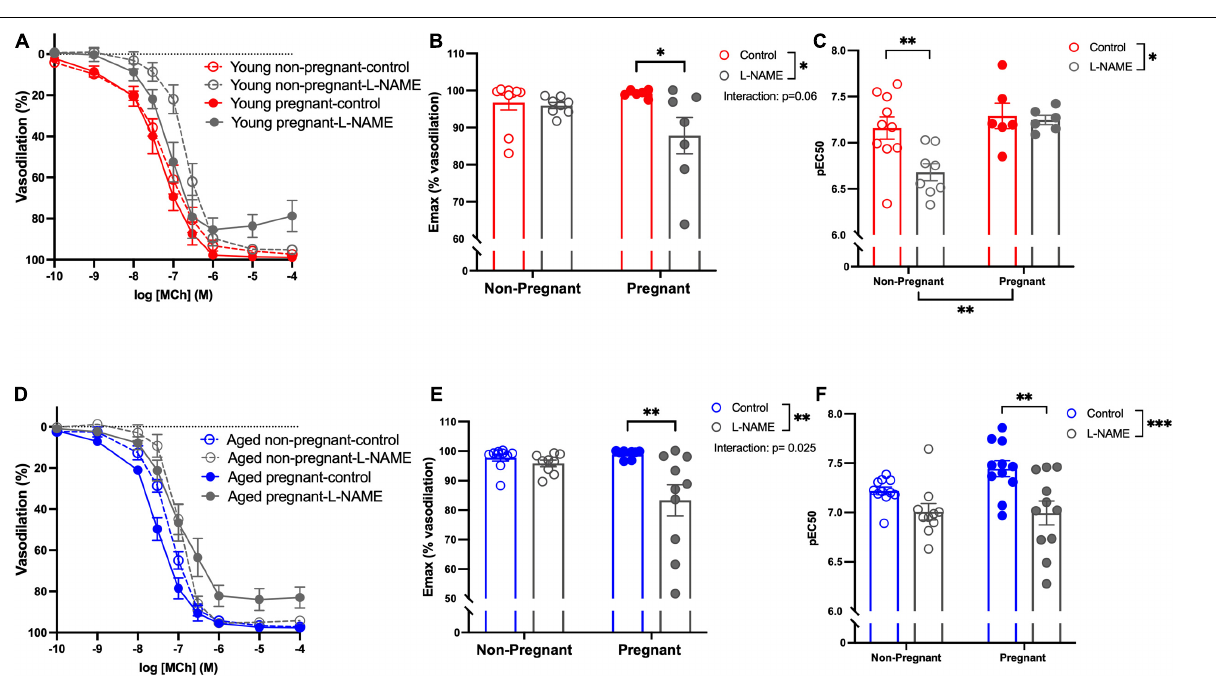
FIGURE 3 | Increased nitric oxide-dependent vasodilation during pregnancy in mesenteric arteries from young and aged pregnant rats. (A,D) Endothelium-dependent vasodilation responses to increasing doses of methylcholine (MCh) in the presence or absence of L-NAME in mesenteric arteries of young [3–4 months; in red; (A–C) ] and aged [9–9.5 months; in blue; (D–F) ] pregnant (on gestational day 20; closed circles) and non-pregnant (age-matched; open circles) rats. (B,E) Data summaries of the maximal vasodilation responses to MCh (E max ). (C,F) Data summaries of the sensitivity to MCh (pEC 50 ). Data are presented as mean ± SEM; analyzed by two-way ANOVA with Sidak’s multiple comparisons post hoc test; ∗ p < 0.05, ∗∗ p < 0.01; ∗∗∗ p < 0.001; n =